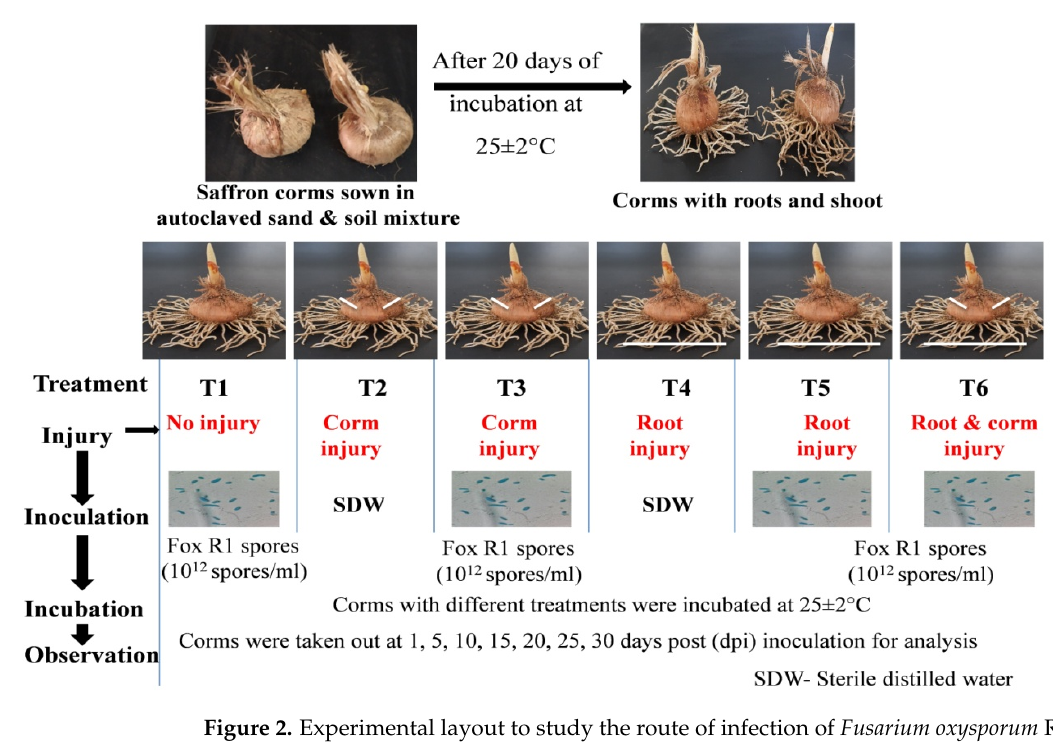
Figure 2. Experimental layout to study the route of infection of Fusarium oxysporum R1 (Fox R1) in the saffron plant.